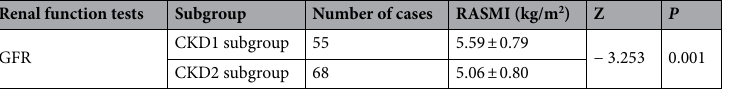
Table 4. Analysis of the relationship between GFR and RASMI. CKD chronic kidney disease, GFR glomerular filtration rate; RASMI relative appendicular skeletal muscle